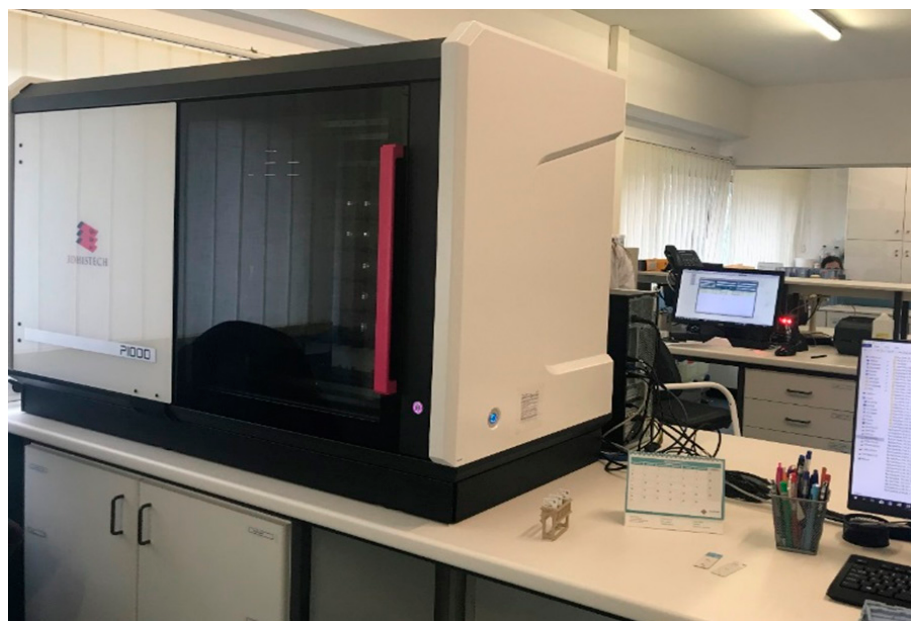
Figure 1. The scanner is located at the heart of the laboratory surrounded by benches where specimens processing takes place.